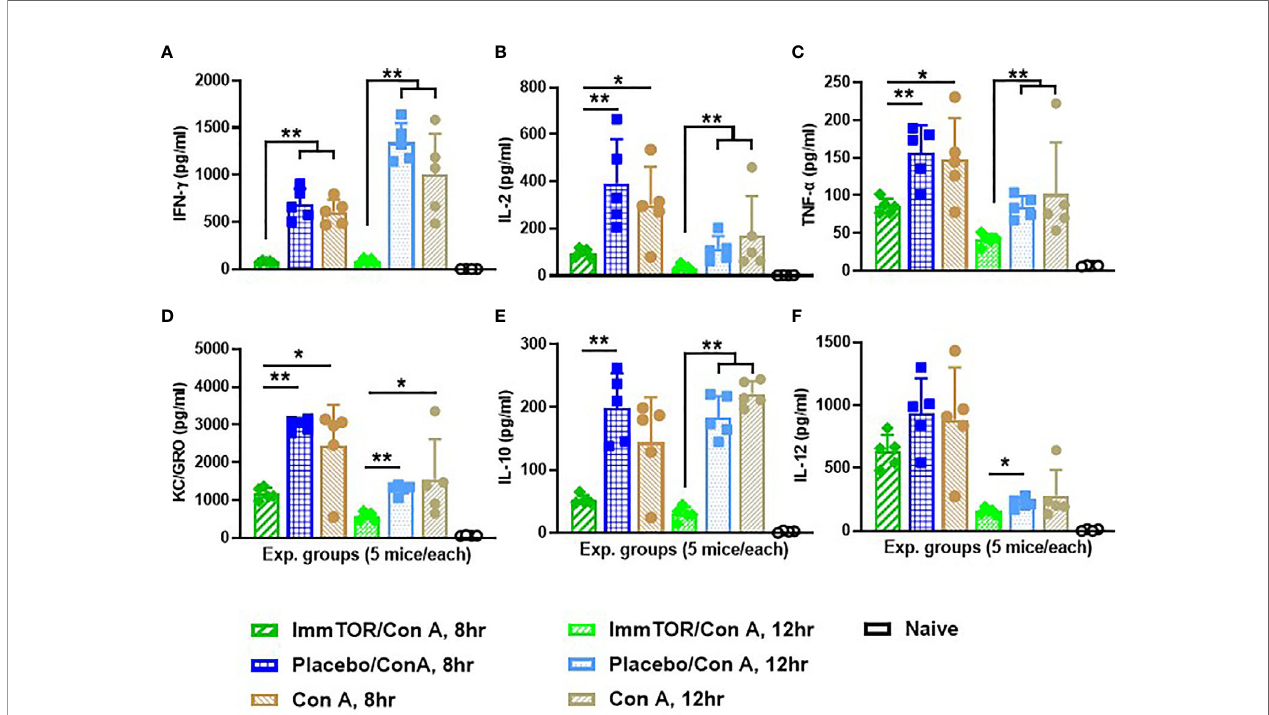
FIGURE 8 | ImmTOR pretreatment diminishes systemic in fl ammatory cytokines after Con A challenge. Six groups of nice (5 each) which were either untreated or injected with ImmTOR or NP-Empty particles (300 µg) were challenged with concanavalin A (12 mg/kg, i.v.) 7 days after the treatment, sacri fi ced 8 or 12 hours later and levels of serum cytokines determined. (A – F) – serum levels of IFN g , IL-2, TNF a , KC/GRO, IL-10, and IL-12 correspondingly, are shown for both post-challenge time-points for all experimental groups vs. that of naïve (no ImmTOR, no Con A) mice with statistical signi fi cance indicated (* – p<0.05, ** – p<0.01; Mann-Whitney test). Experiment was performed twice with essentially the same outcomes and the results of representative study are shown.